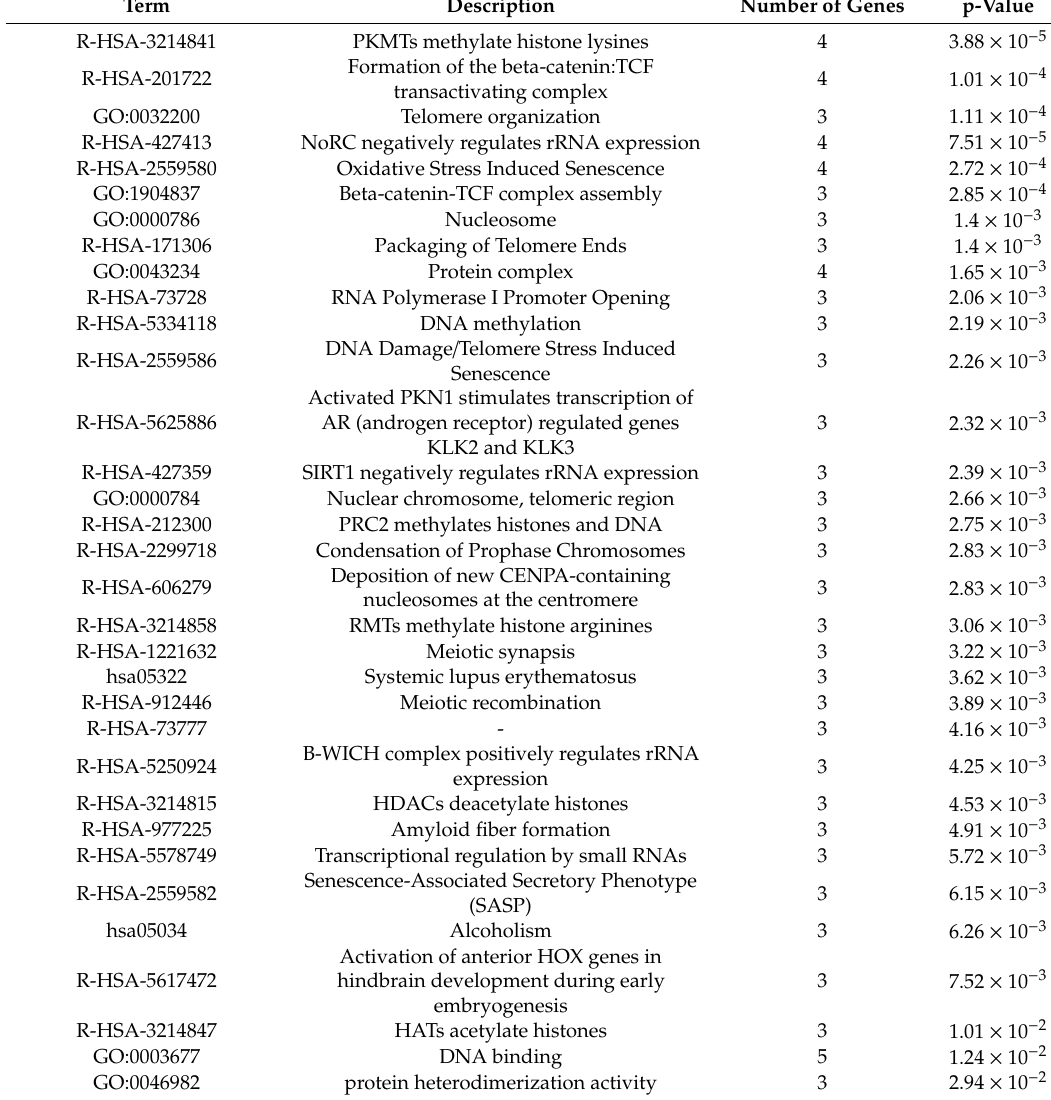
Table 5. Functional annotation clustering on cluster 1.